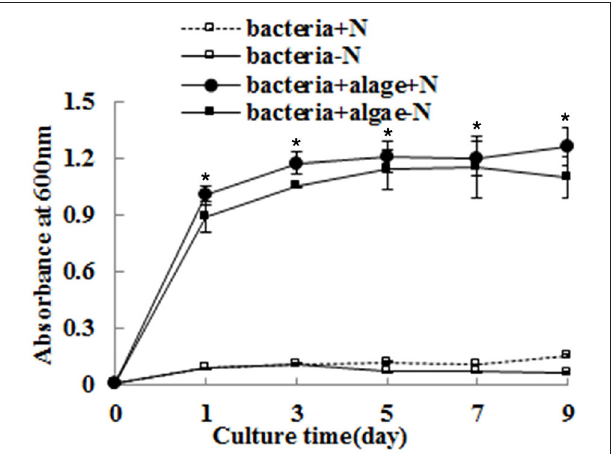
FIGURE 2 | The growth of A. chroococcum co-cultured with algae were measured in TAP and TAP-N media. Pure bacterial culture in both media was used as controls. Light intensity was 200 µ E · m − 2 · s − 1 . The same condition as the algae in the co-culture produced lipids. The volume ratio of bacteria (OD 600 = 1.0) and algae (OD 750 = 1.0) was 1:40. *significant difference between the experimental and control groups. The vertical bars indicate standard errors calculated from at least three independent experiments.